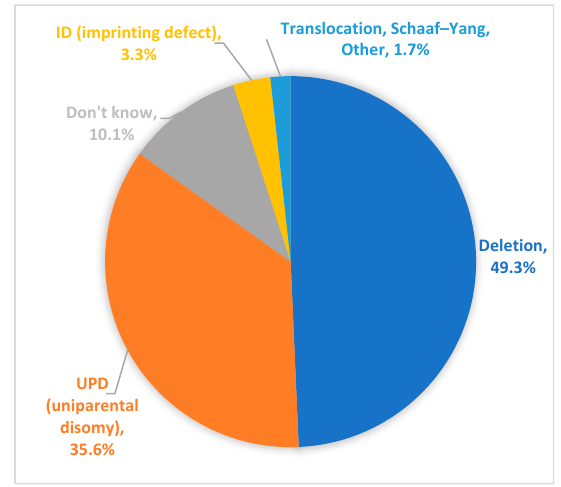
Figure 3. PWS genetic subtype of Registry participants. PWS by deletion is the predominant genetic subtype of participants within the Registry. PWS by uniparental disomy (UPD) is the second most common diagnosis. PWS by imprinting defect, translocation, and micro-deletions are also represented within the Registry. Approximately 10% of Registry participants do not know their PWS genetic